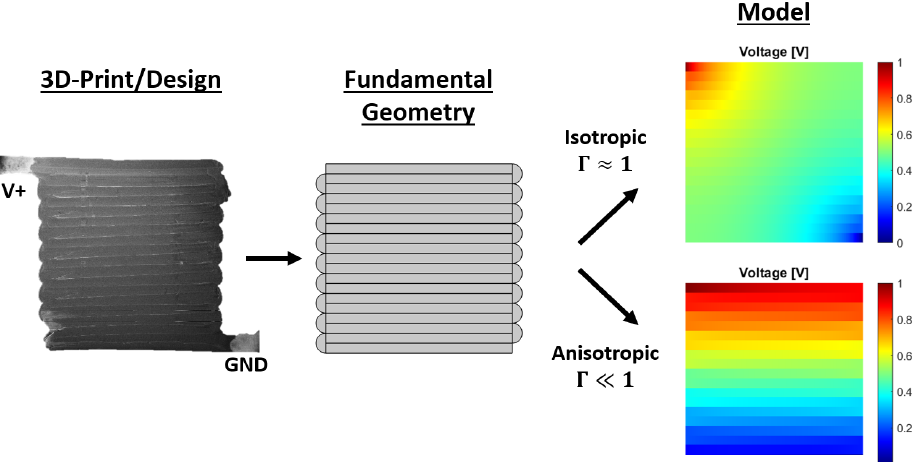
Figure 33. The model can be used to calculate the conduction in 3D-prints from the sample geometry and material properties, over the whole range of conduction behavior from isotropic to anisotropic. The results show that the dimensionless numbers can be used to analyze the type of conduction and the resulting total resistance. Anisotropy ratios that are close to 1 give bulk or isotropic conduction properties. For low aspect ratios, the effect of both